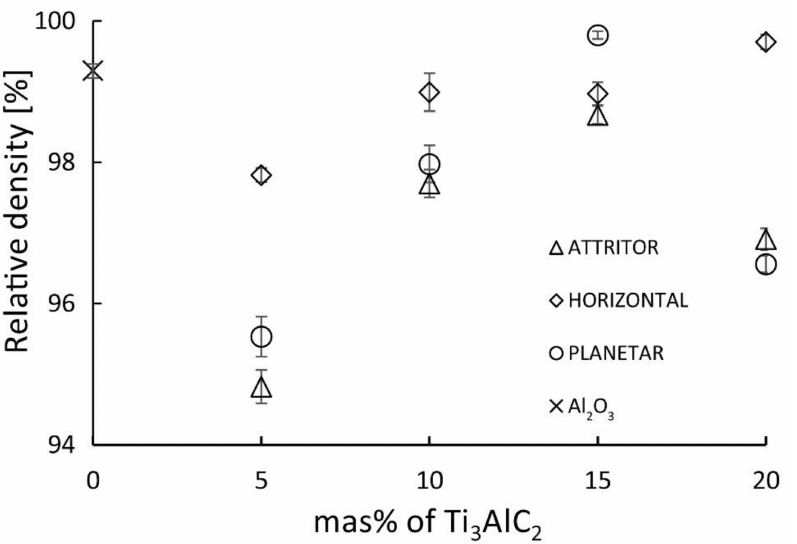
Figure 2. The relative density of Al 2 O 3 /Ti 3 AlC 2